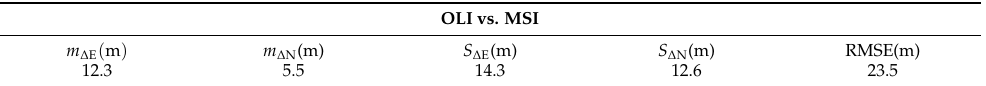
Table 2. Relative co-registration error statistics: mean (m), standard deviation (S) of Easting ( ∆ E) and Northing ( ∆ N) differences, and root-mean-square error (RMSE).